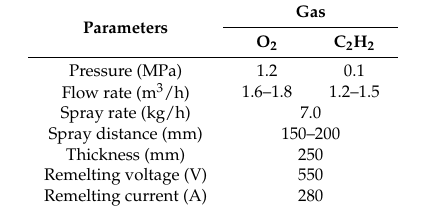
Table 2. Oxy ‐ acetylene flame spraying parameters.